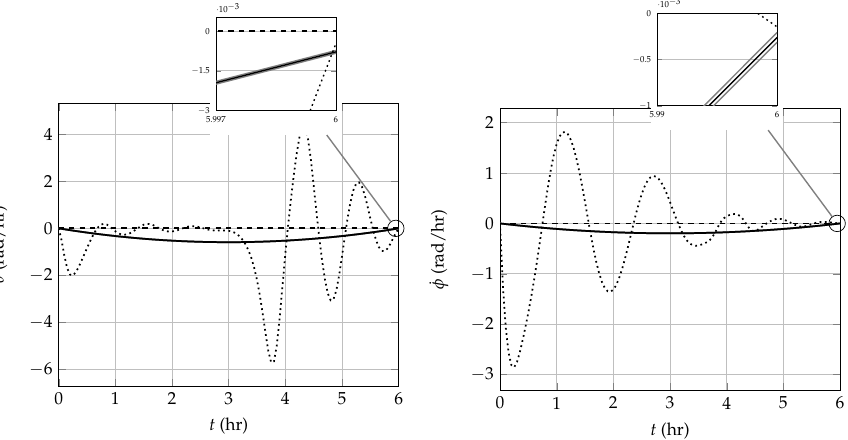
Figure 3. Angular velocity trajectories of the spacecraft. The black curves are the angular velocities of the actual nonlinear system whereas the gray curves are the angular velocities of the auxiliary linear systems. The dashed line is the desired velocity at final time and the dotted line a solution using a non-convex